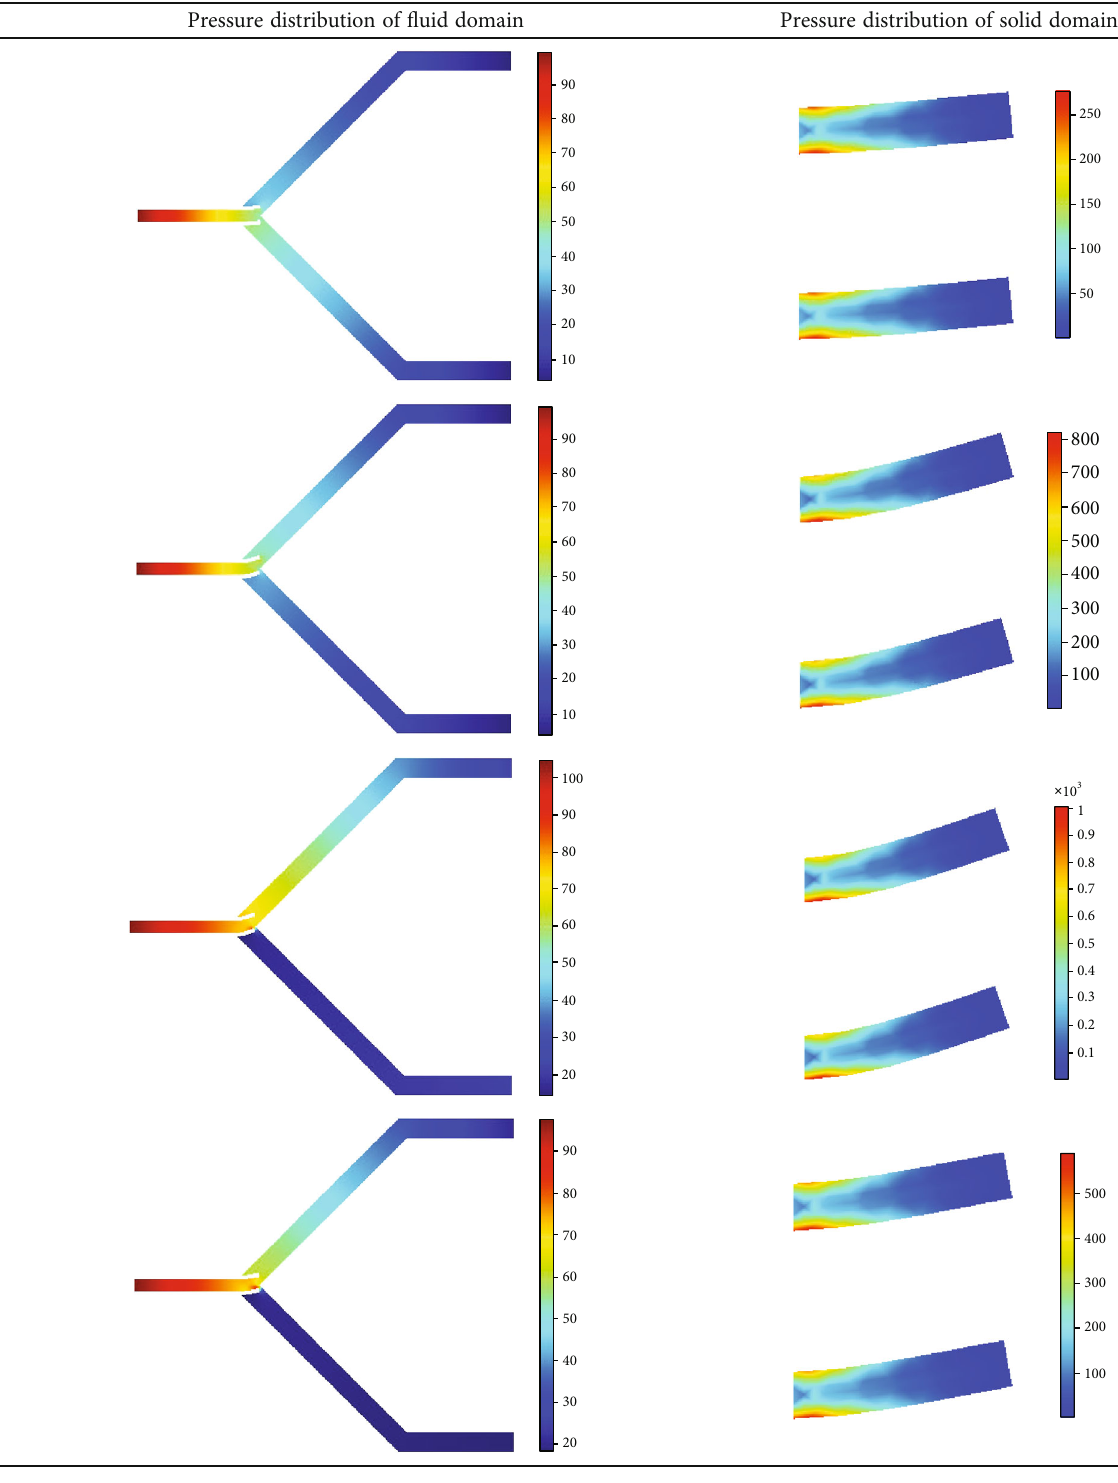
Table 3: Pressure change over a